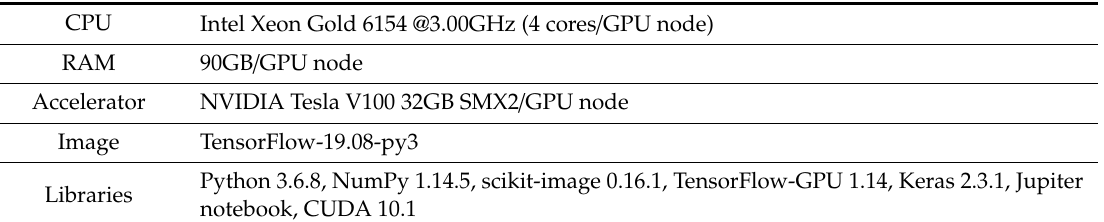
Table 4. Computation resource for model training, validation, and testing.